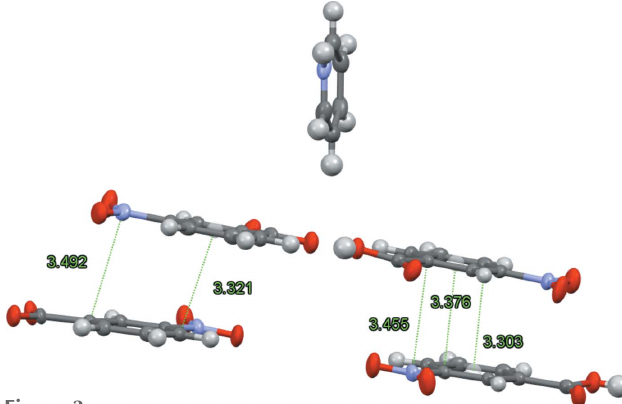
Figure 3 Depiction of the (cid:2) interactions in the title structure. Lines in green display multiple close points of contact between the aromatic rings. Distances in A˚ .